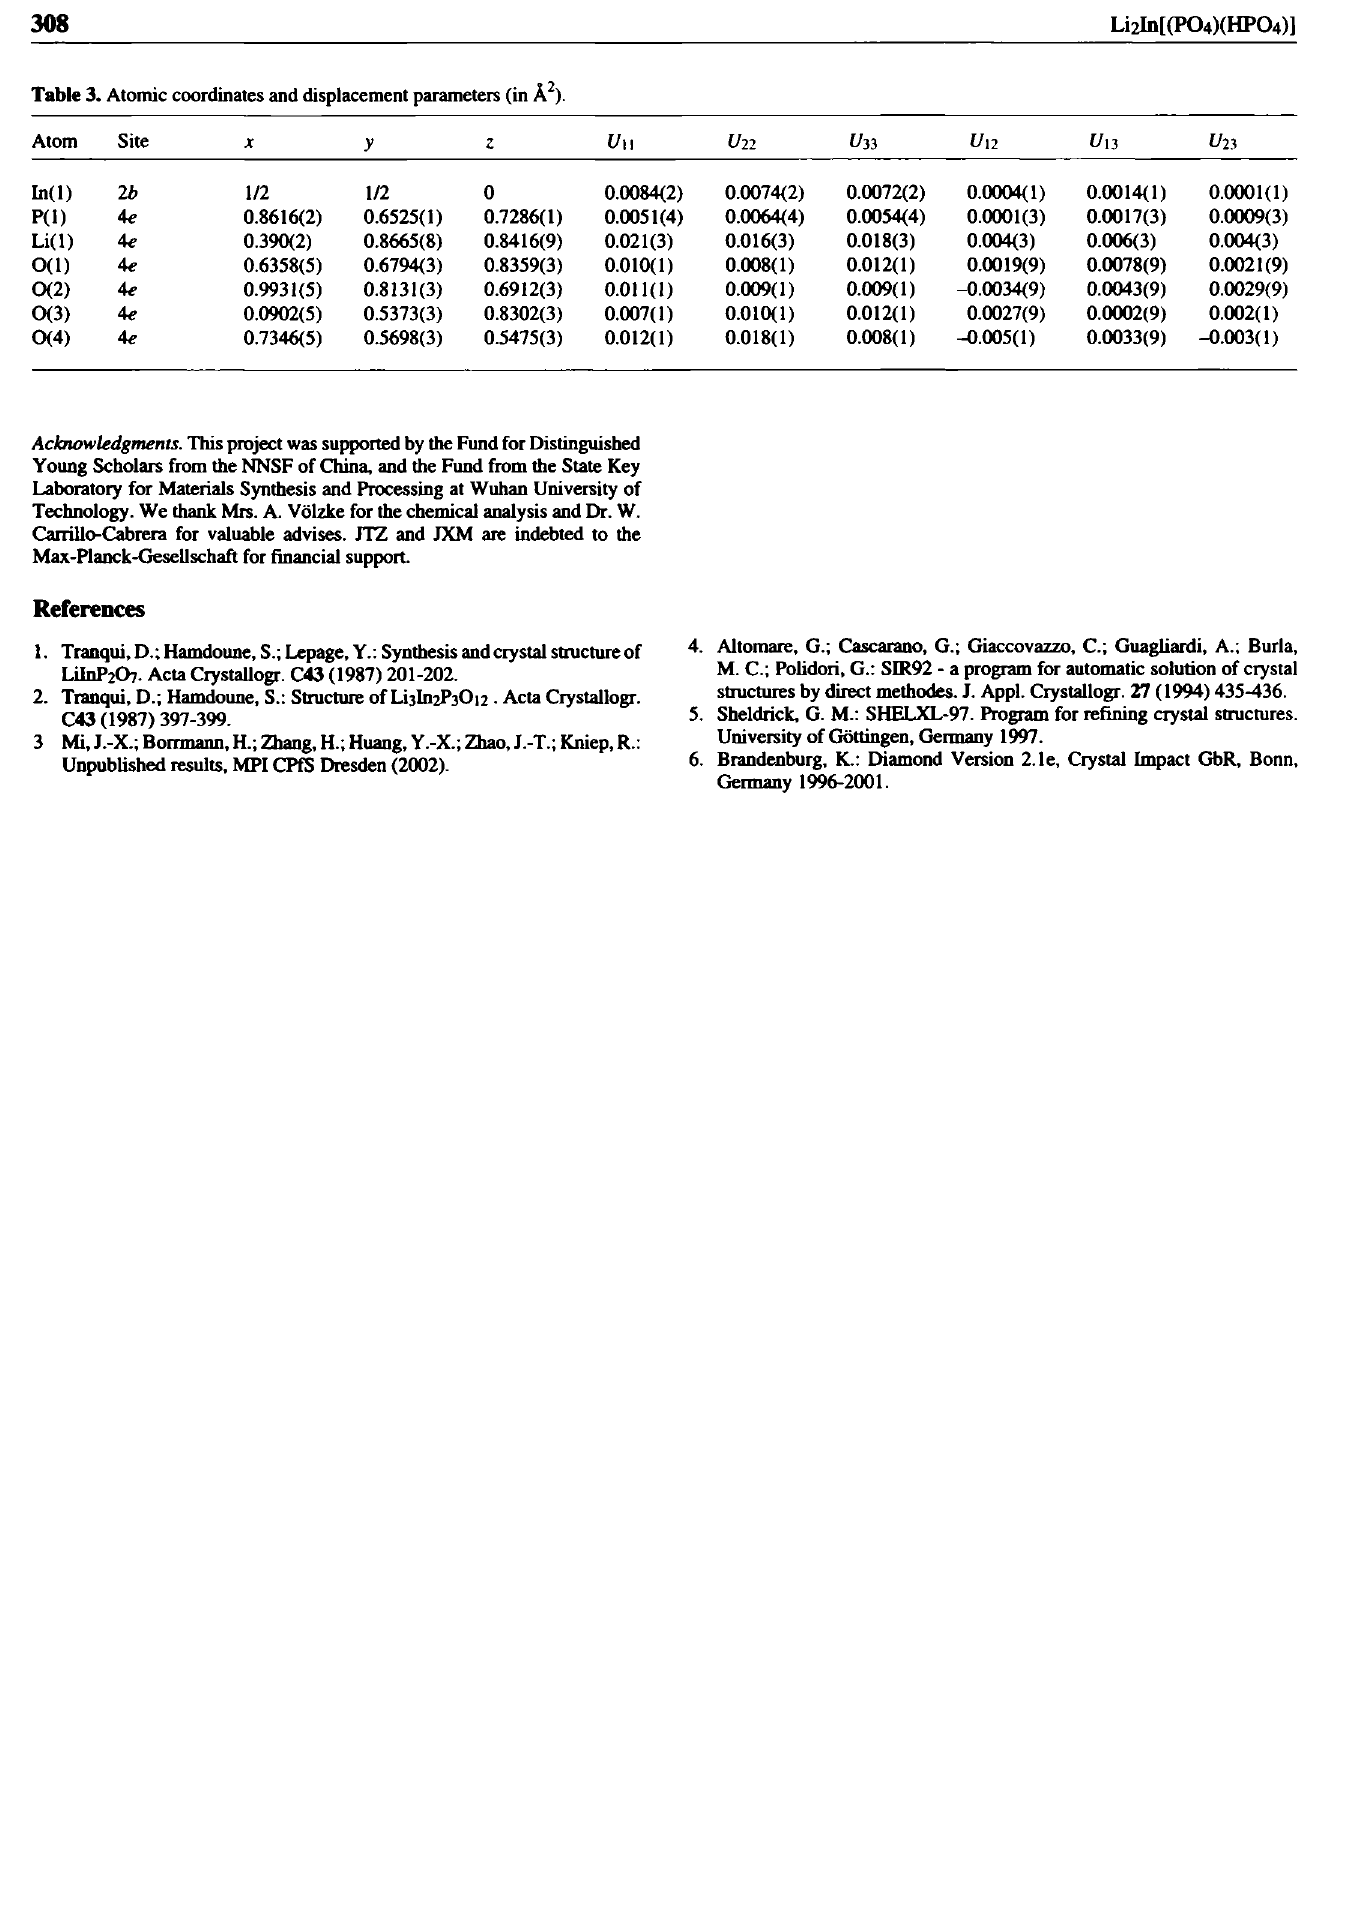
Table 3. Atomic coordinates and displacement parameters (in Â 2